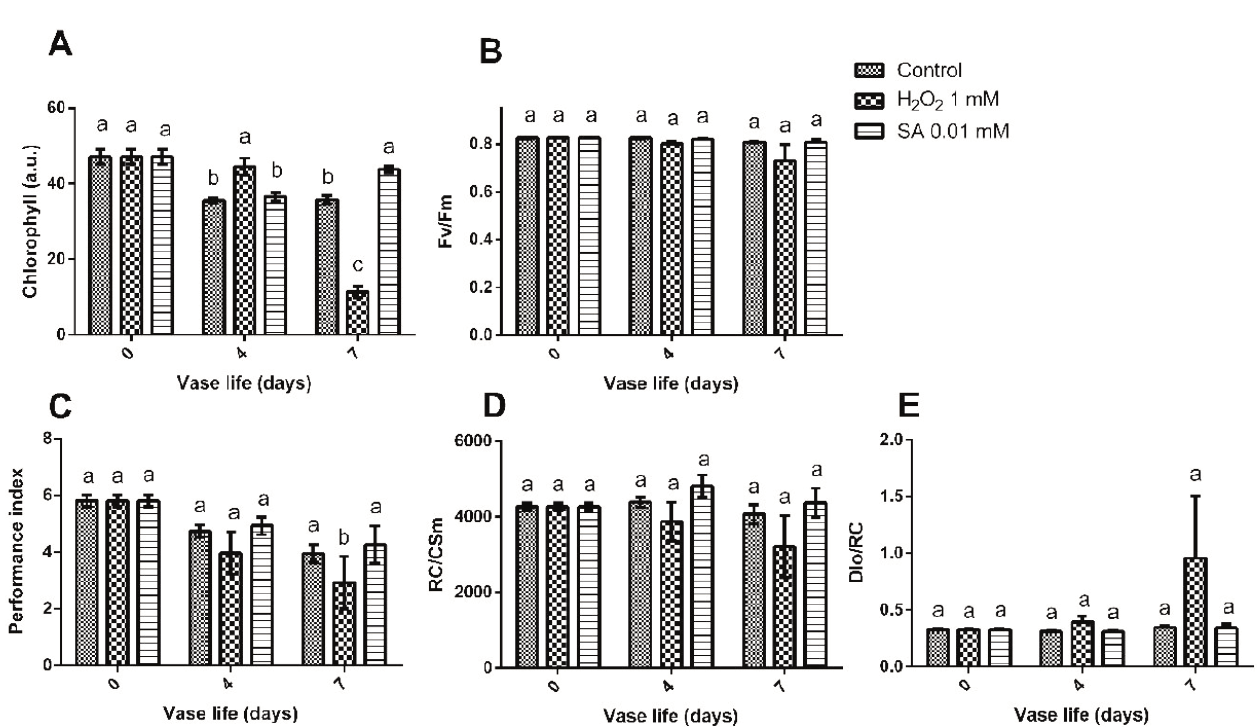
Fig. 3 - Chlorophyll content (A) and chlorophyll a fluorescence-related indexes: maximum quantum efficiency of PSII (Fv/Fm) (B), perfor- mance index (PI) (C), number of reaction centers per cross section (RC/CSm) (D), energy dissipated per reaction center (DIo/RC) (E). Measurements were conducted on leaves of cut ‘Tacazzi’ rose. Data are means ± SE (n=6). Different letters indicate signifi- cant differences